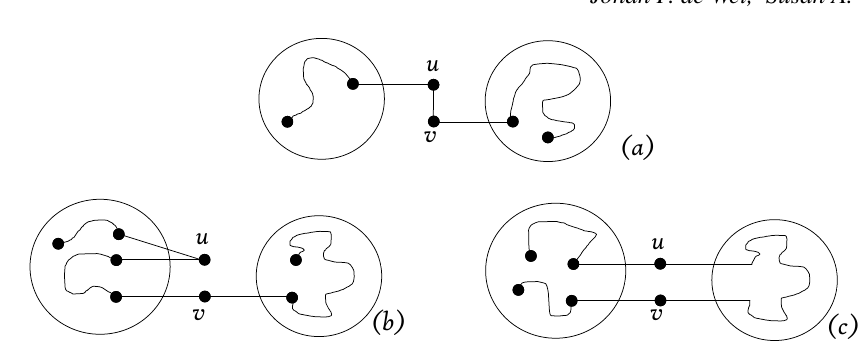
Fig. 3: Edge identification preserves LT and nontraceable properties.